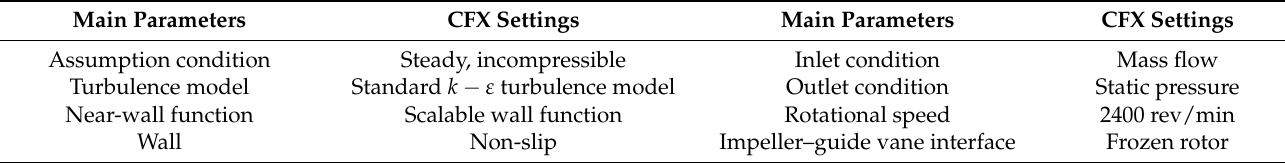
Table 2. Parameter settings for steady